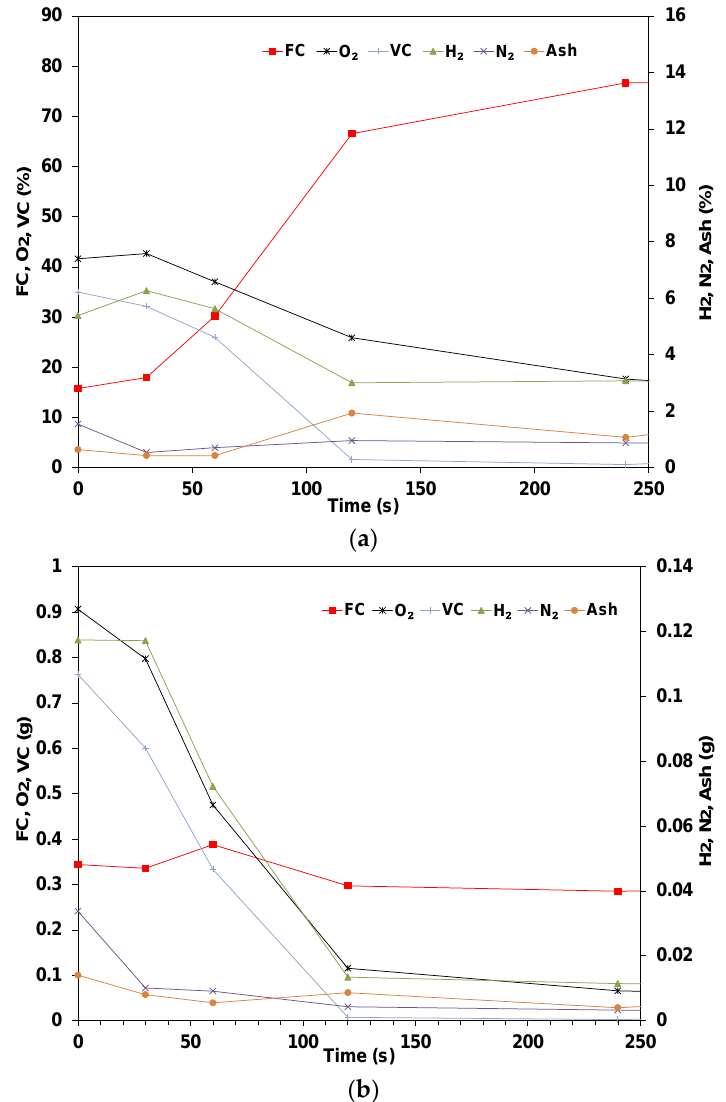
Figure 9. Elemental analysis of wood pellets at 650 °C: ( a ) in percentages and ( b ) in grams.